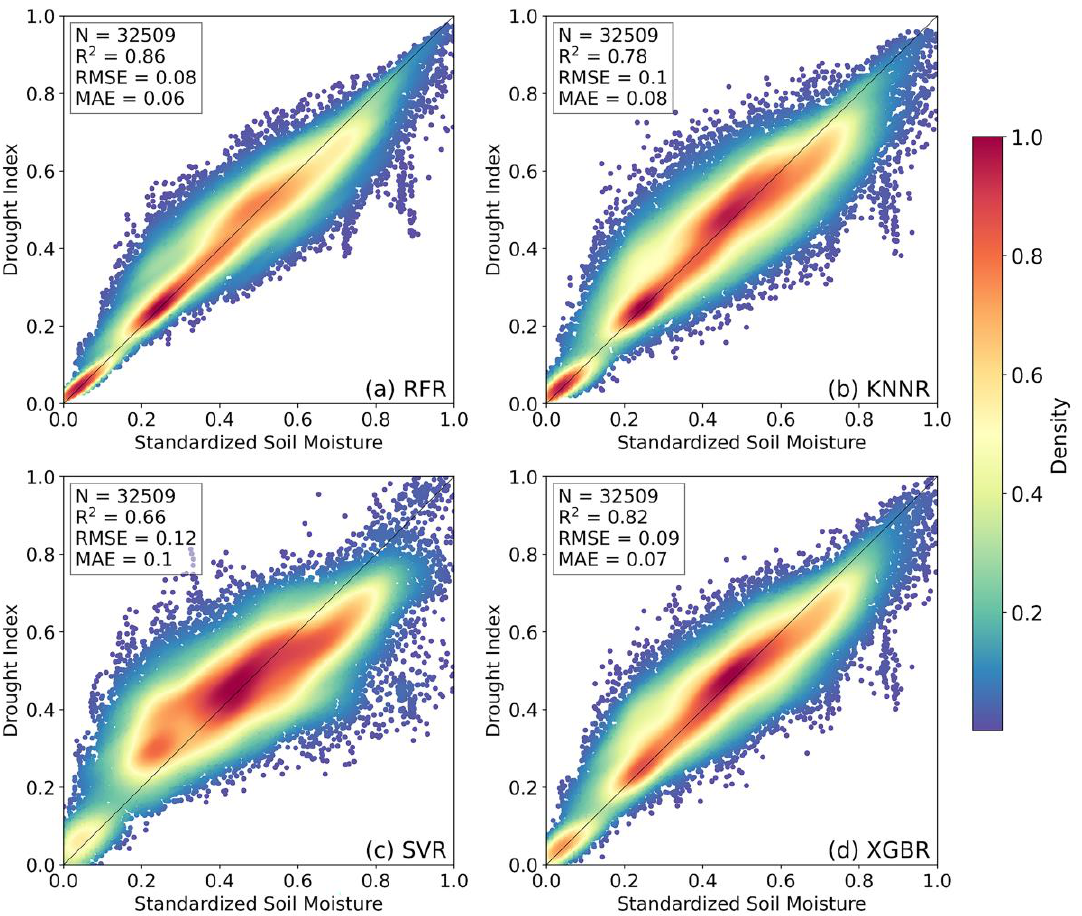
Figure 3. Comparisons of drought indices using four machine learning models with the in situ soil moisture in the training process: ( a ) RFR, ( b ) KNNR, ( c ) SVR, and ( d ) XGBR. Colors represent data density: the redder the color, the larger the data density is.